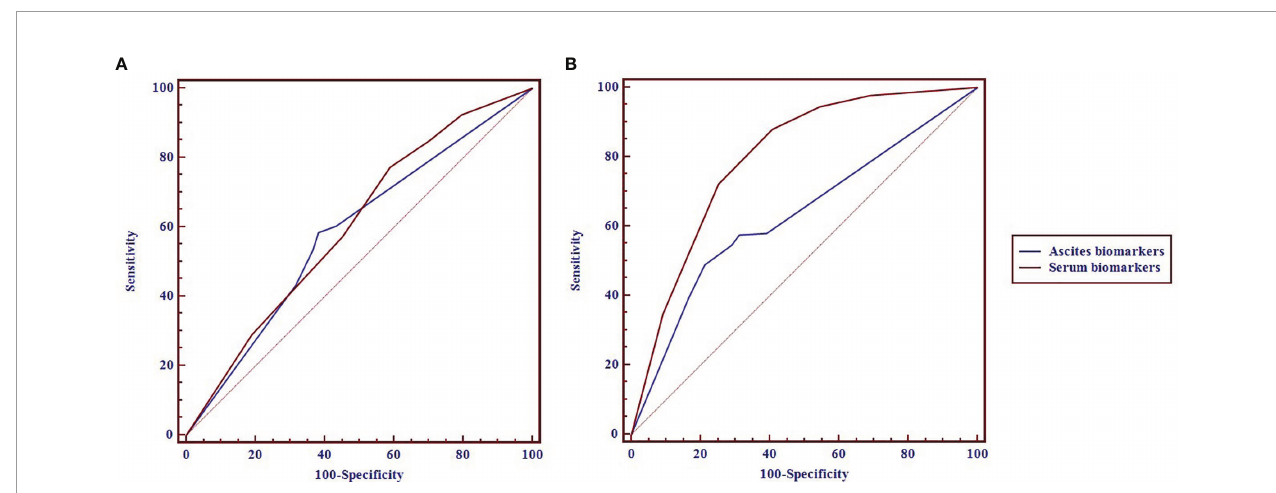
FIGURE 1 | The receiver operating characteristic (ROC) curves of the serum and ascites biomarkers in diagnosis of pathology (A) and completeness of cytoreduction (CC) (B) in pseudomyxoma peritonei (PMP)